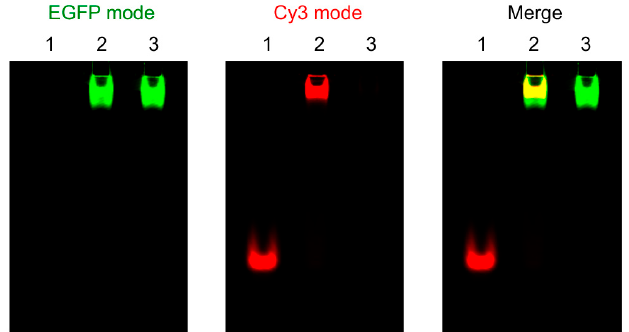
Figure 6. Visualization of Z-RNA and Z α -EGFP protein. Lane 1: Z-RNA only, Lane 2: RNA + Z α -EGFP, Lane 3: Z α -EGFP only. The different modes are indicated in upper. [RNA] = 1 µ M, [Z α -EGFP] = 10 µ M, [NaCl] = 100 mM, [Tris-HCl (pH7.0)] = 10 mM, [DTT] = 5 mM, 10% glycerol, 10 µ g/mL BSA. Z-RNA: r(CGCGUGCG)-Cy3/r(C[m 8 Gm]CAC[m 8 Gm]CG).